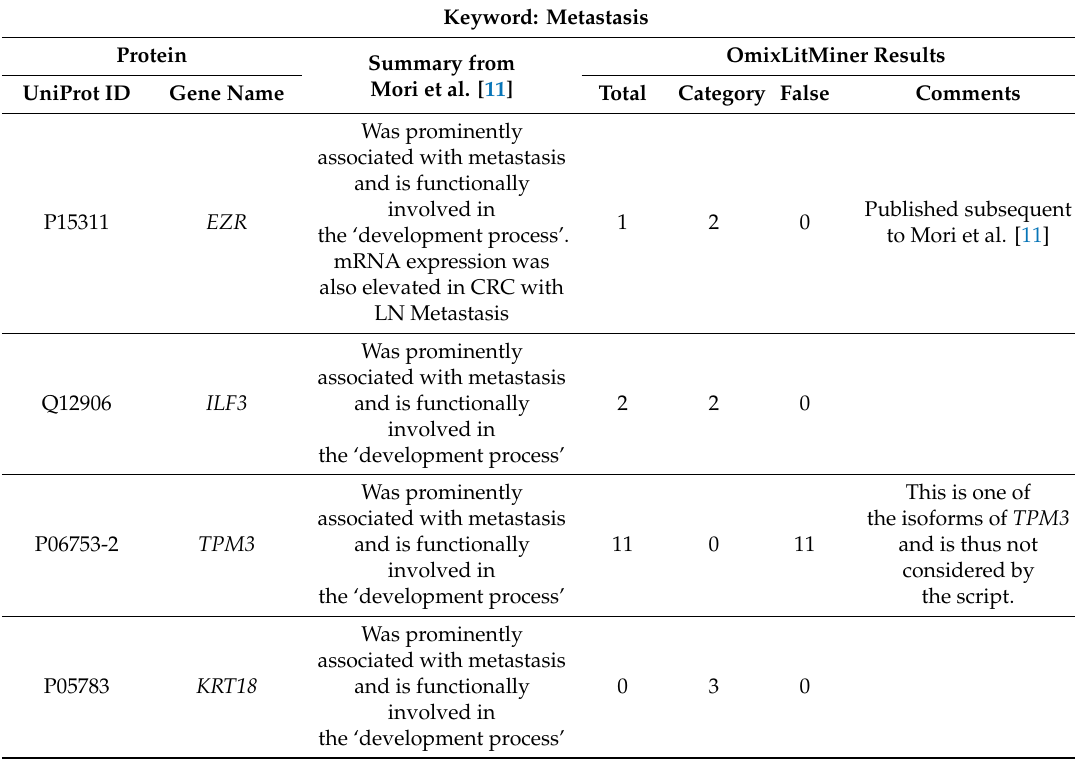
Table 3. Extract from OmixLitMiner from the list of 55 proteins reported in the supplement of Mori et al. [11] using the keyword